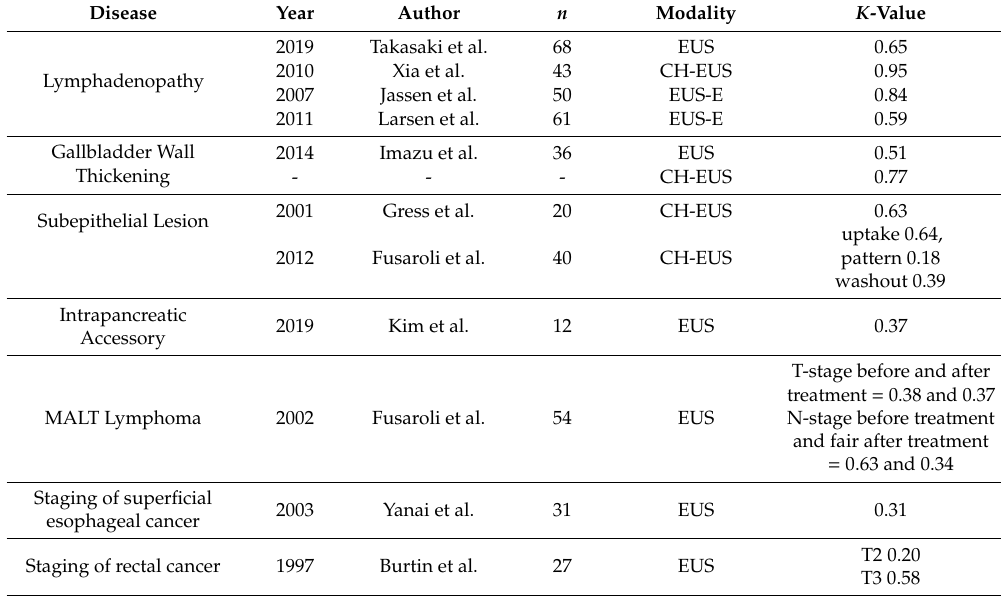
Table 4. Interobserver reliability of EUS criteria in other